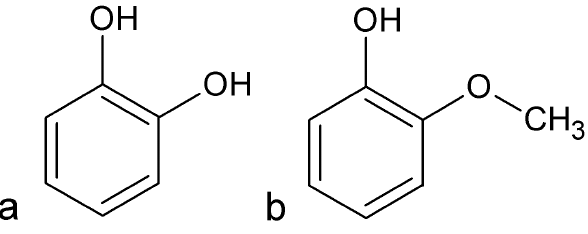
Fig. 1. The used SOA precursors: (a) catechol (Benzene-1,2-diol), (b) guaiacol (2- methoxyphenol)